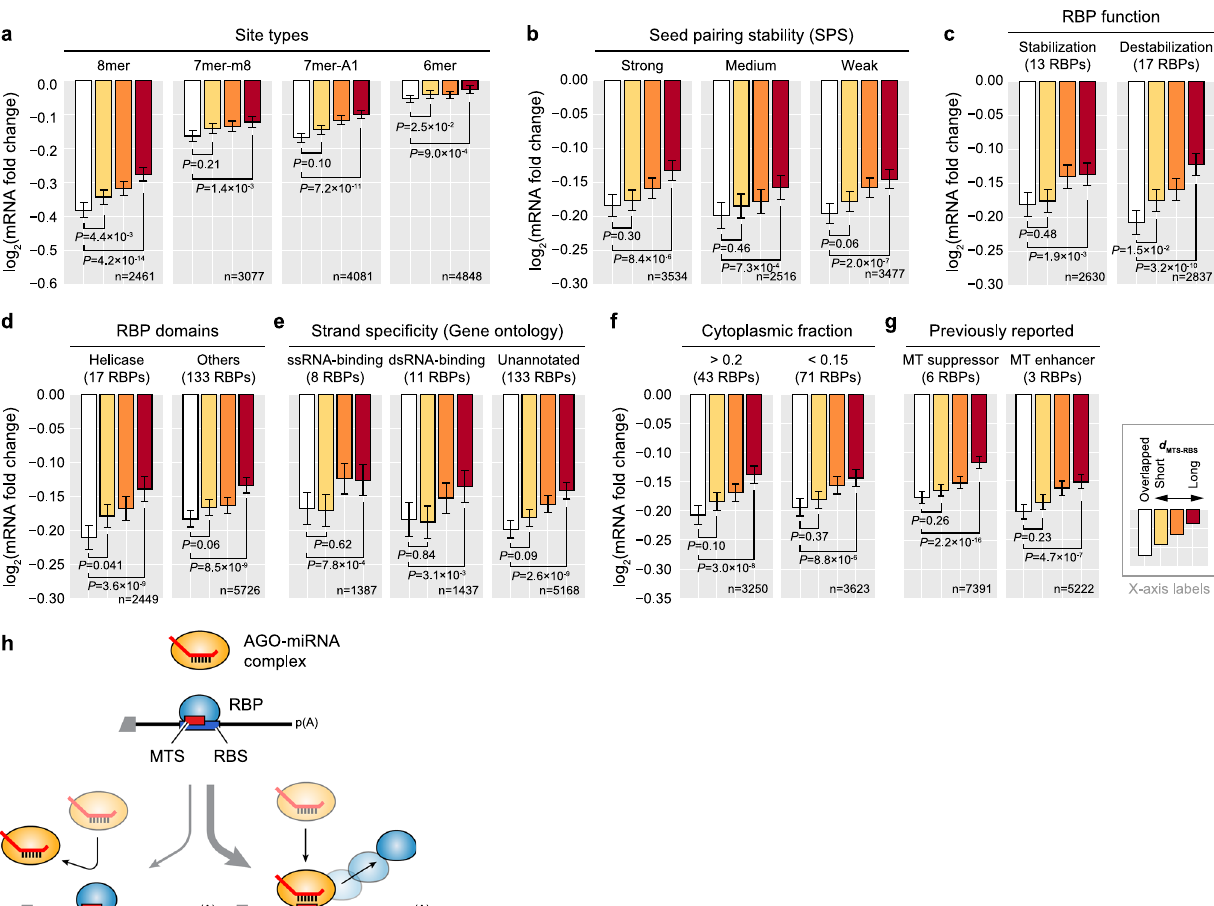
Fig. 6 miRNA targeting is regulated by a wide range of RBPs. a – g Association analysis of the distance between a miRNA target site (MTS) and the nearest RBP-binding site (RBS) on the 3 ′ UTR, denoted as d MTS-RBS , with MT ef fi cacy for different site types, seed-pairing stabilities (SPSs), and various properties of RBPs. A subset of 3 ′ UTRs depicted in Fig. 1d were selected with respect to different site types ( a ), SPSs ( b ), function of RBPs on mRNA stability ( c ), helicase activity ( d ), strand speci fi city ( e ), subcellular localization ( f ), and previously reported function of RBPs on MT regulation ( g ). The selected 3 ′ UTRs were split into four subgroups with respect to d MTS-RBS . Each subgroup was carefully chosen to have statistically indistinguishable confounding features among four subgroups, and mRNA fold changes were compared (see Supplementary Fig. 5b for full versions). Otherwise as in Fig. 1d. h Schematic illustration of the MT mechanism for the MTS that overlaps with an RBS. Before AGO-miRNA complex binds to the MTS, RBPs can bind to their RBS (top). One possible scenario afterwards is that the RBP binding competes against miRNA-bound AGO preventing it from productive MT (bottom left). However, our results support the other scenario where miRNA-bound AGO predominantly replaces mRNA-bound RBPs leading to productive MT (bottom